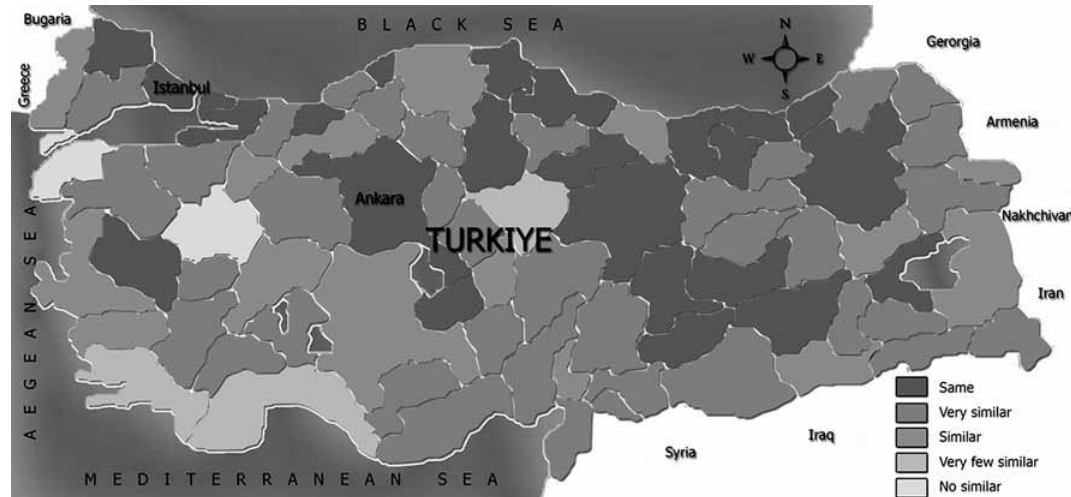
Fig. 3. Map of road network